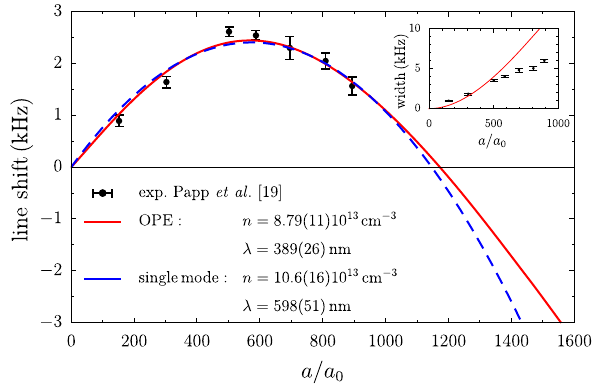
FIG. 4. Line shift of a repulsive Bose gas as a function of scattering length a . The line shift [Eq. (50)] predicted by the operator product expansion is indicated by a red continuous line. For comparison, we include the line shift [Eq. (53)] as predicted from the single-mode ansatz (blue dashed line). Inset: OPE prediction [Eq. (51)] for the width of the Bragg peak. The black points are the experimental results by Papp et al.